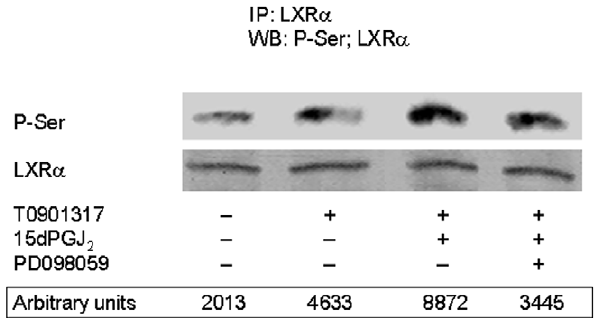
Figure 7. 15dPGJ 2 promotes LXR a serine phosphorylation in human neutrophils. Neutrophils were preincubated at 37 u C with or without 30 m M PD098059 for 30 min. Then the cells were treated or not with 10 m M 15dPGJ 2 for 30 min, and thereafter stimulated or not with 1 m M T0901317 for further 30 min. Finally, the cells were lysed, LXR a was immunoprecipitated and Western blotting analysis of phosphoser- ine (P-Ser) and LXR a levels was carried out as indicated in Experimental Procedures. P-Ser levels are given in arbitrary units. The blot is representative of a set of three experiments yielding similar results.